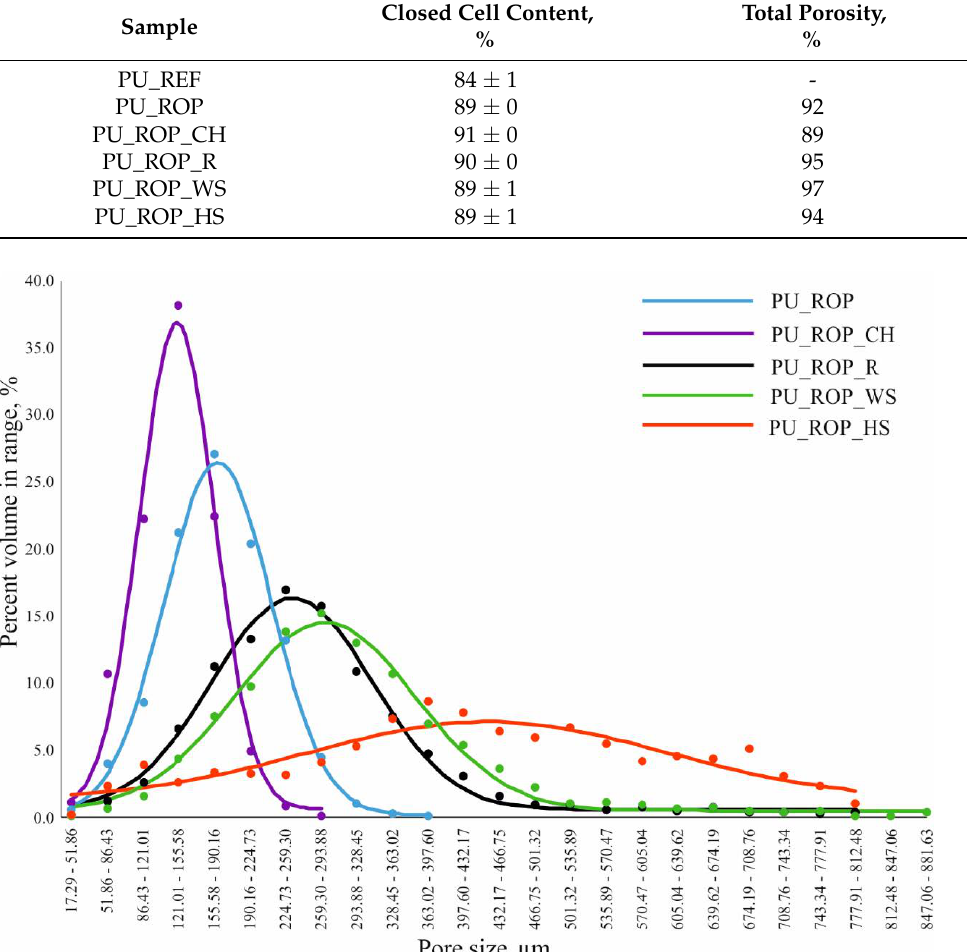
Table 3. Closed cell content (ISO 4590) and total porosity (CT) of the analyzed materials.